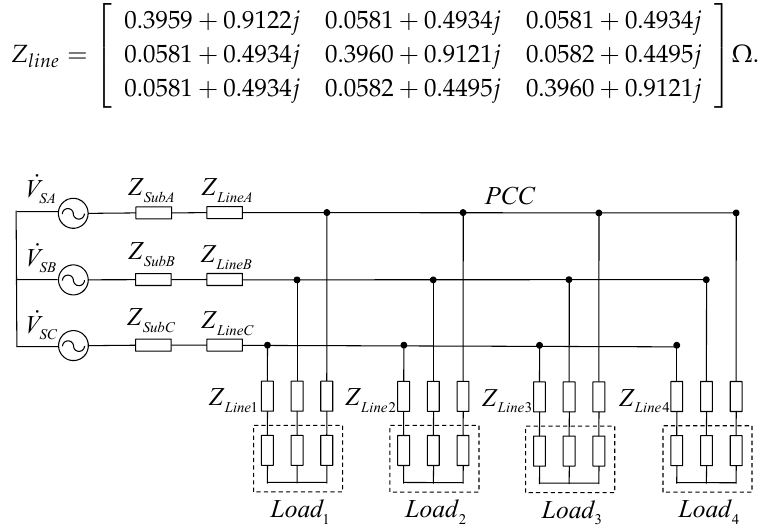
Figure 6. Schematic circuit of the case study system.